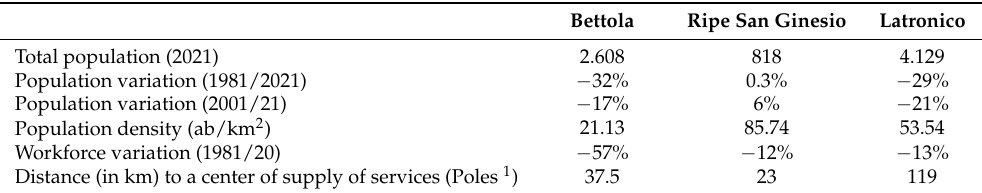
Figure 1. Localization of the three case studies on the map of the peripheral and ultra-peripheral areas as classified by the National Strategies of Inner Areas (SNAI). Source: elaboration by the authors. Table 1. Geographical and socio-economic data of the municipalities where the three case studies are located. Source: elaboration by the authors using ISTAT data.